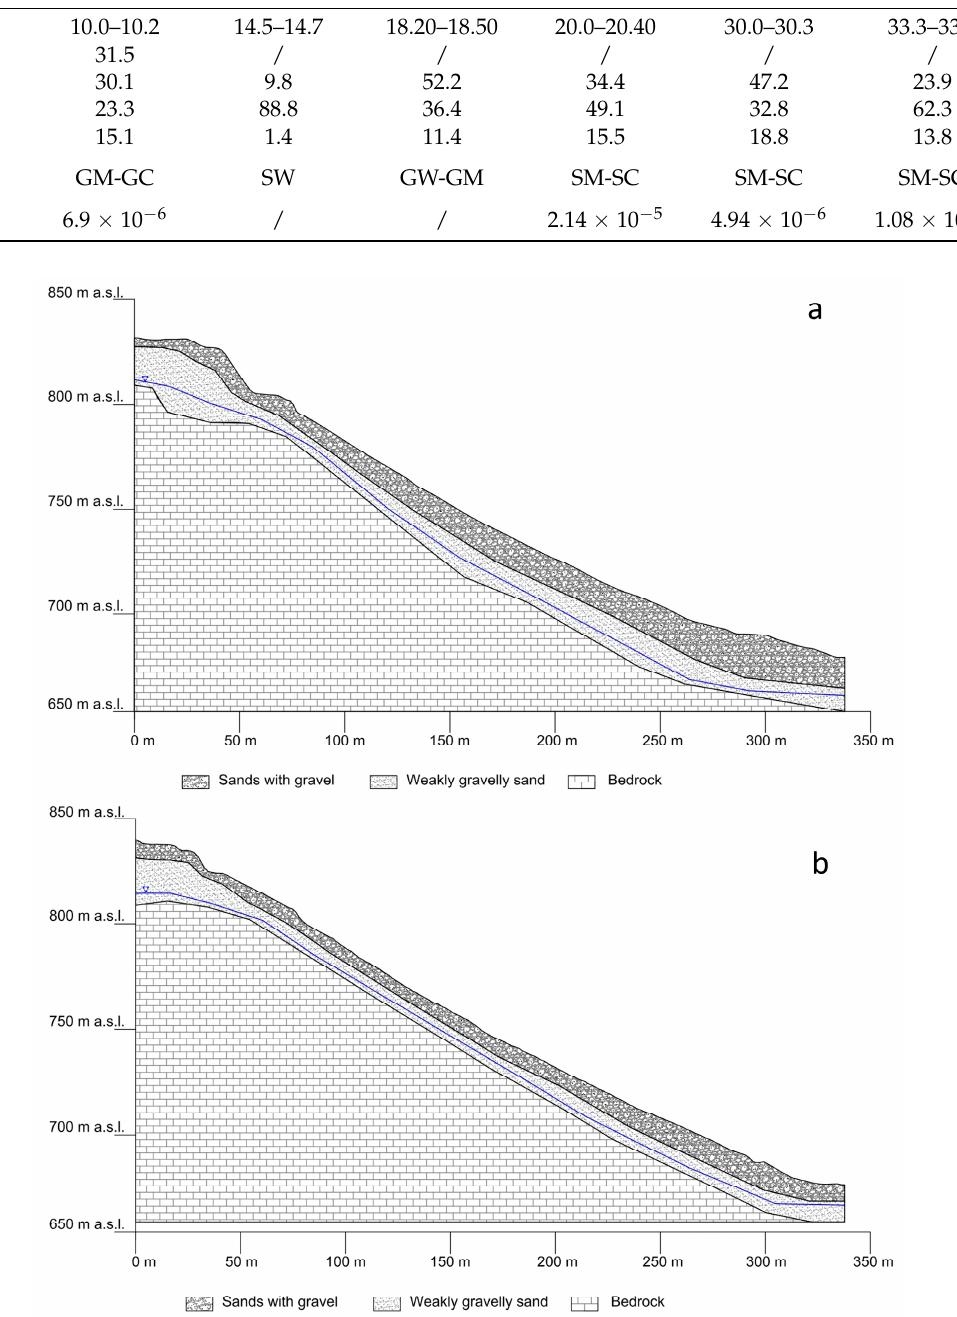
Figure 7. ( a ) Geological section along the A-A’ profile; and ( b ) geological section along the B-B’ pro fi le. Table 2. Summary of the geotechnical parameters of the four samples collected from the Theilly landslide. K = permeability constant load test; w = water content; φ′ = friction angle; and c ′ = cohesion.